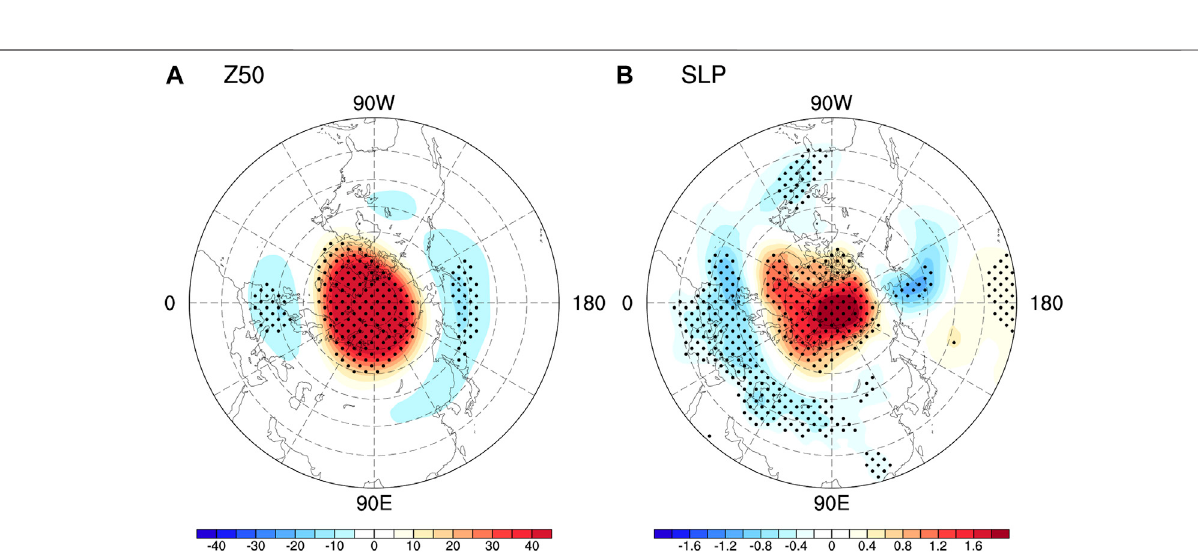
Frontiers in Earth Science |